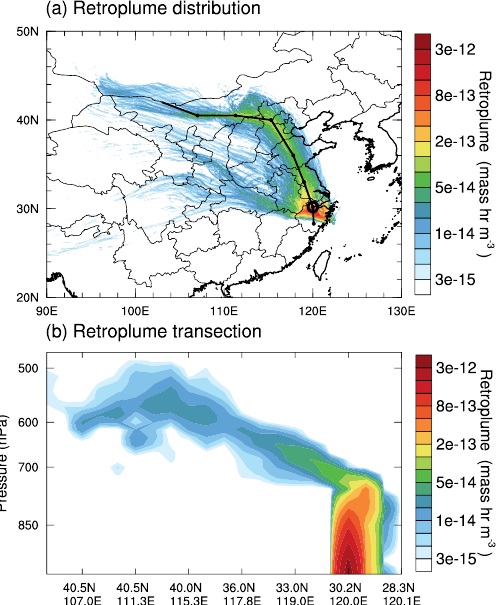
Figure 10. Time evolution of vertical distributions of water vapour divergence ( a , g s − 1 cm − 2 hPa − 1 ) and vertical velocity ( b , Pa/s), at Hangzhou (120 ◦ E, 30.2 ◦ N) from 24 April 2018 to 30 April 2018. The water vapour divergence and vertical velocity are calculated by ERA5 data.